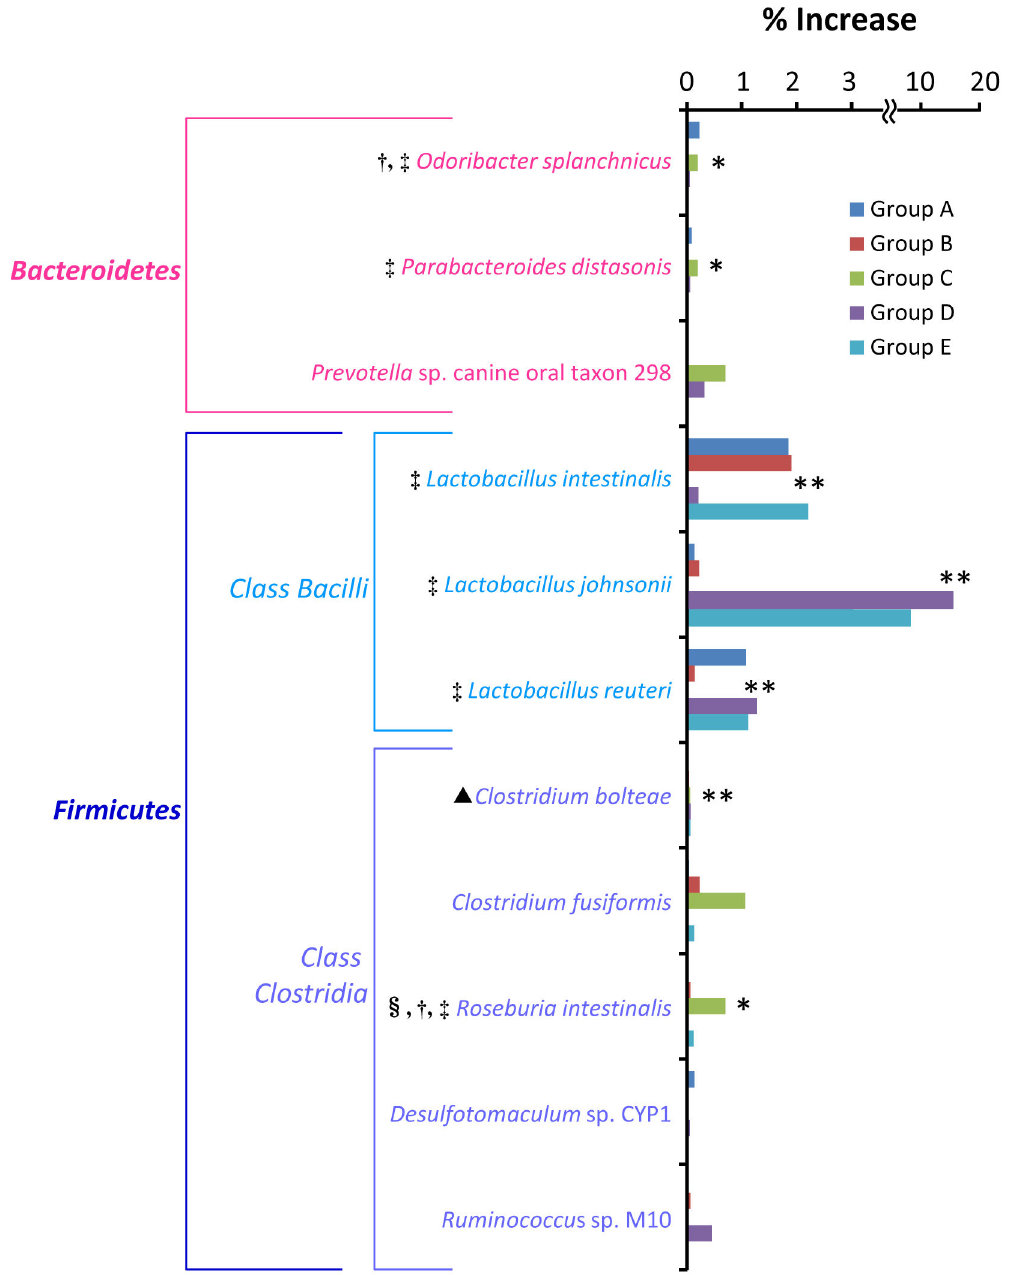
Figure 5. Bacterial phylotypes in the large intestine whose population level increased upon PG-administration. Percent increase was calculated by subtracting the percent population level of each specific phylotype found in the PG-administered mice with that found in the PBS control mice. Associations between bacterial phylotypes and PG administration were examined by Fisher exact test. The phylotypes having P values less than 0.05 at least in 2 groups (see Table S8) are shown. Asterisks * and ** indicate bacterial phylotypes having P values less than 0.05 in 3 and 4 groups, respectively. §: Saccharolytic bacteria, †: short-chain fatty acids-producing bacteria, ‡: bacteria with immunomodulatory effect, ▲: disease-associated bacteria.